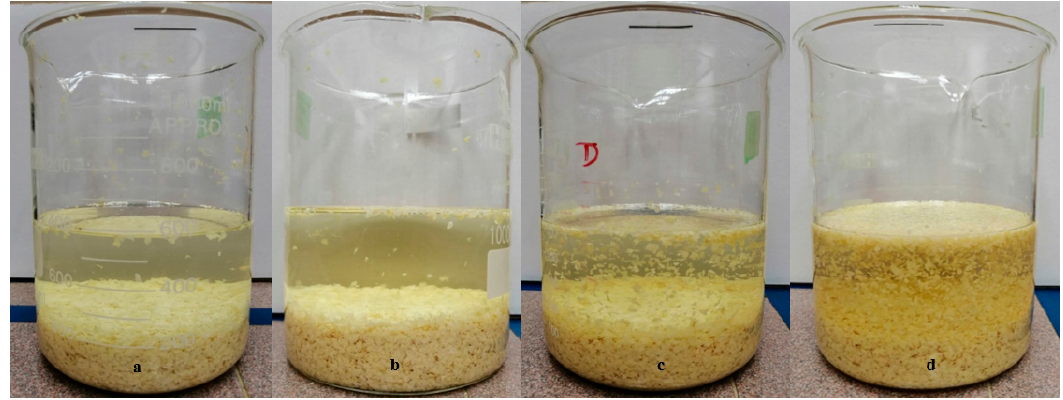
Figure 1. Rubber crumbs surface treatment using NaOH solution: ( a ) 1%, ( b ) 4%, ( c ) 7%, and ( d ) 10%.